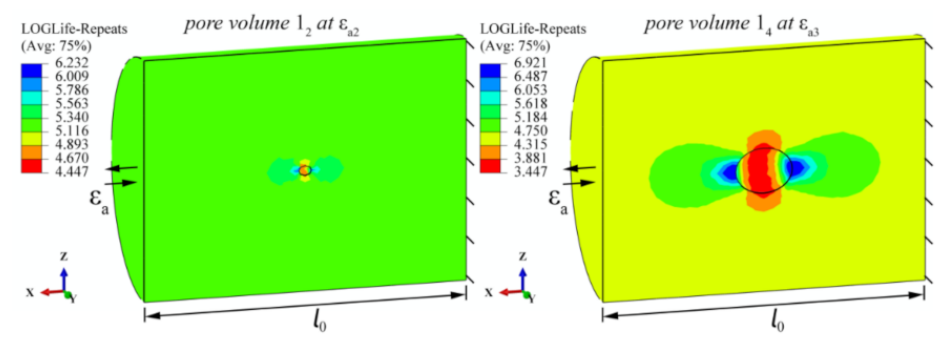
Figure 8. Two examples of numerical calculations of fatigue lives (in LOGLife form) for pores 1 2 (at ε a2 ) and 1 4 (at ε a3